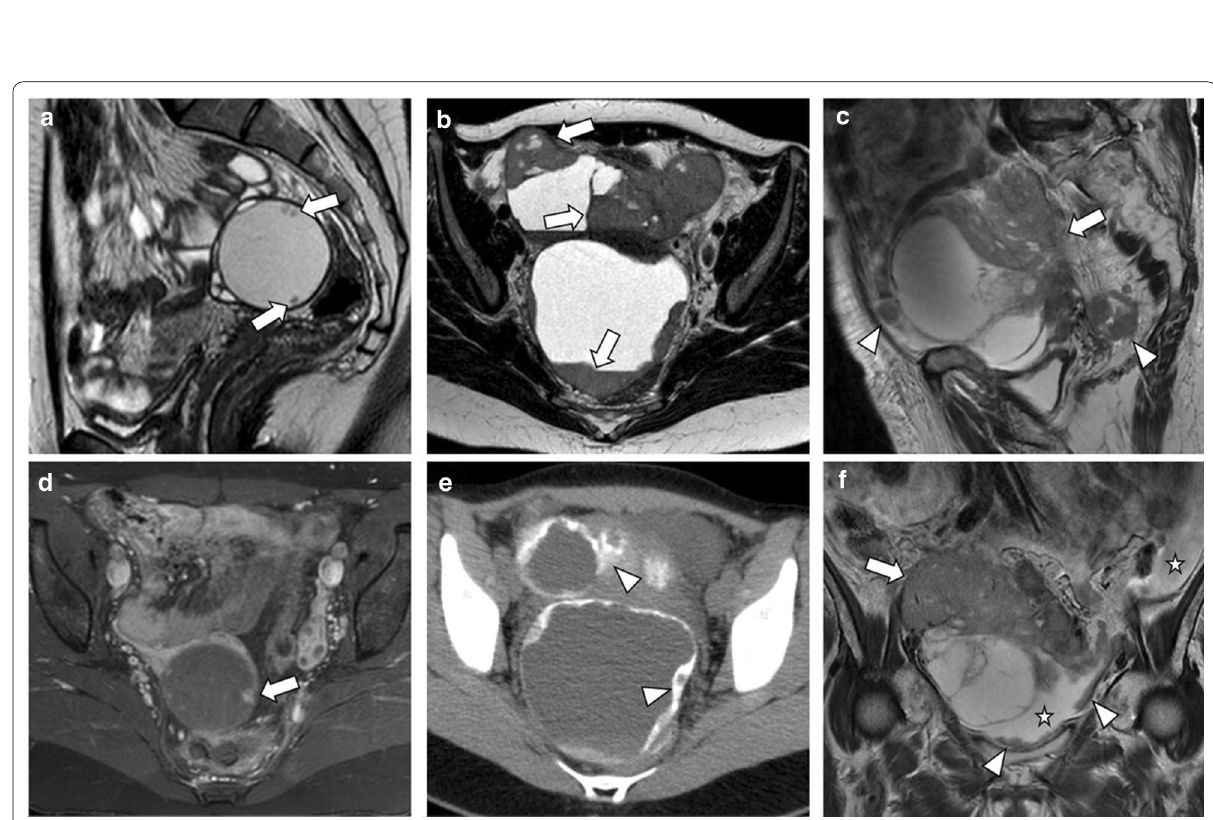
Fig. 7 Three cases demonstrating the main radiological features of SBT, LGST and HGST. Sagittal T2-weighted image ( a ) and axial fat saturation T1-weighted image after gadolinium administration ( d ) reveal a right unilocular cystic tumour with well-defined margins and small enhancing papillary projections (arrows). Histologic examination was compatible with SBT. Axial T2–weighted MR image ( b ) and axial unenhanced CT image ( e ) show a bilateral mixed LGST with solid parietal components (arrows) and calcified psammoma bodies (arrowheads). Sagittal and coronal T2-weighted images ( c and f ) demonstrate a bilateral mixed HGST with irregular contours and exuberant solid components (arrows). Several abdominal (not shown) and pelvic peritoneal metastases (arrowheads) and ascites (stars) were